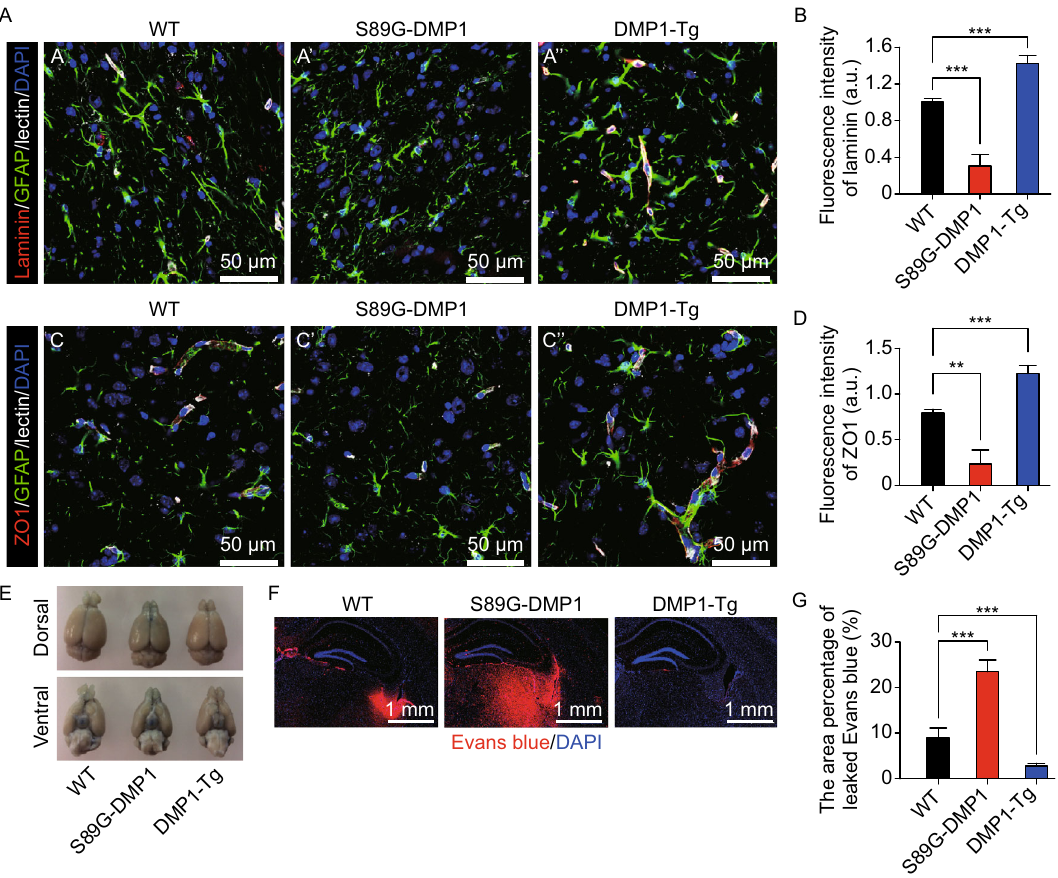
Figure 4. Dmp1 overexpression could resist the reversible opening of blood-brain barrier caused by mannitol. Mouse retrosplenial granular cortex showing expression of laminin (A) and ZO1 (C) at lectin-labeled vasculature, with GFAP immuno fl uorescence; (B) Quanti fi cation of (A); (D) quanti fi cation of (C); **, P < 0.01, ***, P < 0.001, mean ± SEM; a.u. represents arbitrary unit. At least 9 random captures from 3 mice per genotype were quanti fi ed. (E) Brains dissected from mice injected with Evans blue intraperitoneally immediately after tail vein injection of mannitol; (F) After perfusion, brain sections were used to examine Evans blue directly under fl uorescent microscope. (G) Quanti fi cation of (F). ***, P < 0.001, mean ± SEM (Scale bar: 500 μ m). At